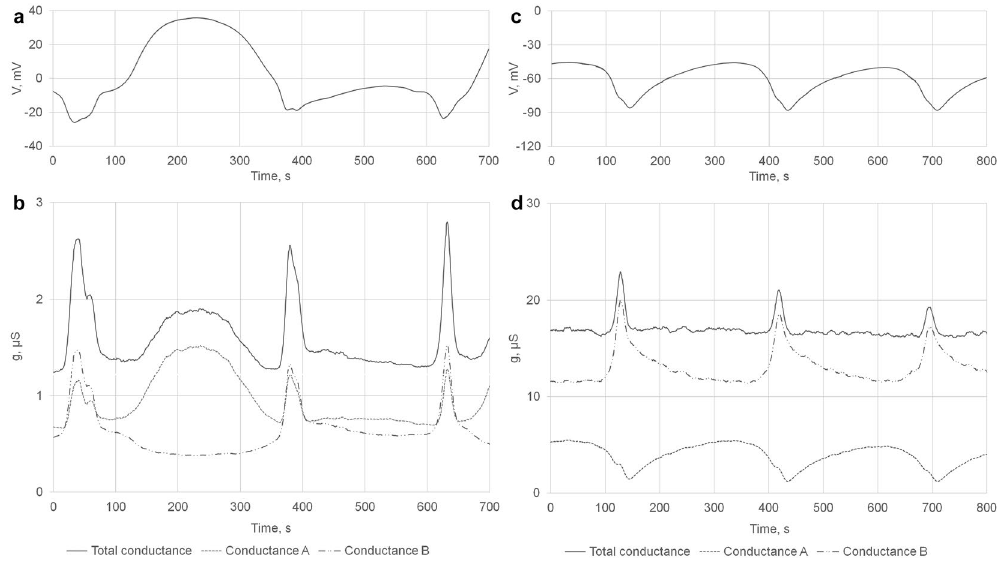
Figure 4. Unusual patterns of defecation motor program oscillations. ( a , b ) In the second cycle depolarizing “bump” dependent on g a1 is missing. ( c , d ) Rhythm generated by g a displayed only one, apparently g a2 peak. As in Fig. 3c for ( b , d ) membrane conductance (solid line) is divided in g a (dotted line) and g b (dash-dotted line) components according to the